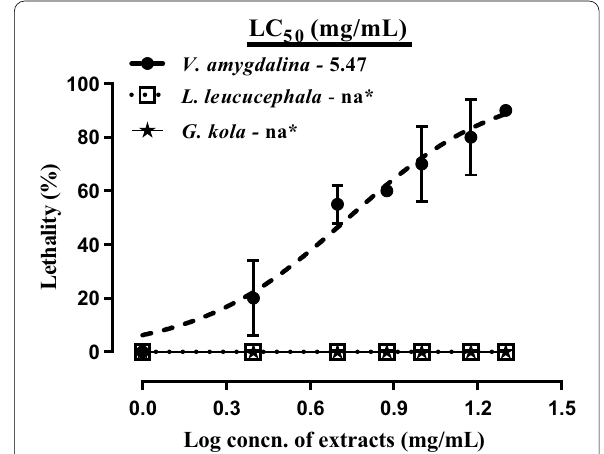
Fig. 3 Anthelmintic activities of the plants’ acetone extracts (1–20 mg/mL) against adult Haemonchus placei . Each value represents two replicates of two independent experiments after 3-h exposure at ambient temperature (26 ‒ 30 °C). *na indicates ‘not